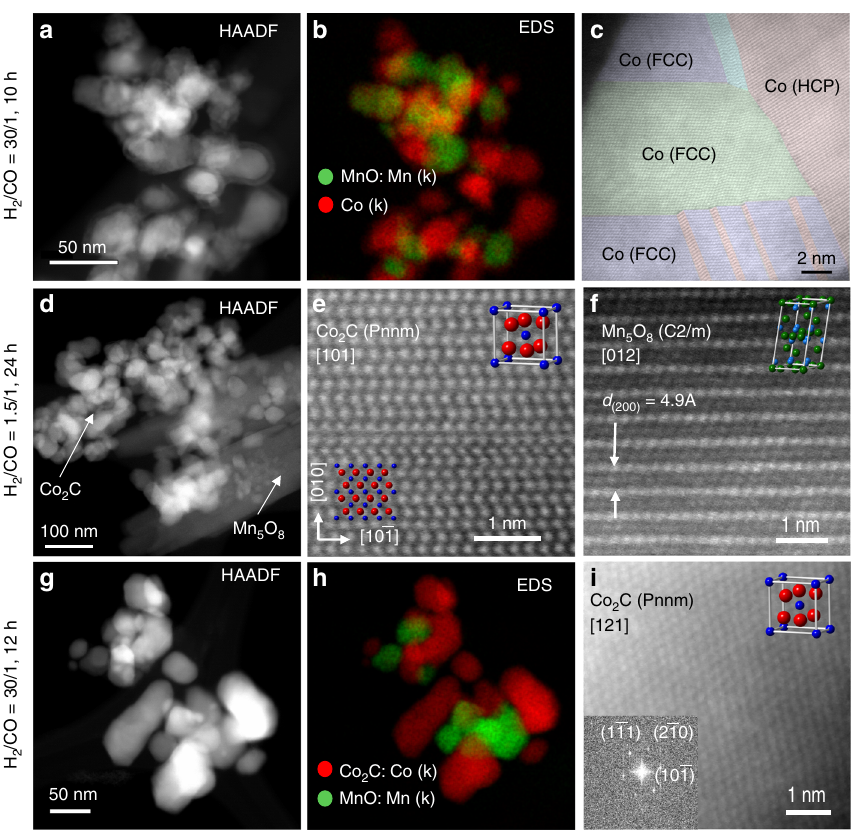
Fig. 4 HRTEM images along with EDS chemical mapping. The TEM image of the Co 4 Mn 1 K 0 . 1 catalyst was obtained after CO hydrogenation at 220 °C, P total = 40 bar. The partial pressure ratio is cycled between a – c : H stream (TOS): a – c fresh catalyst after 12 h TOS, d – f : fresh catalyst after 24 h TOS, g – i : catalyst subjected to H 2 /CO = 1.5 for 12 h fi rst (as in d – f ), then to successively increasing H 2 /CO ratios up to 30 (for another 12 h TOS). Scale bar for HAADF 50 nm, scale bar for HRTEM 1